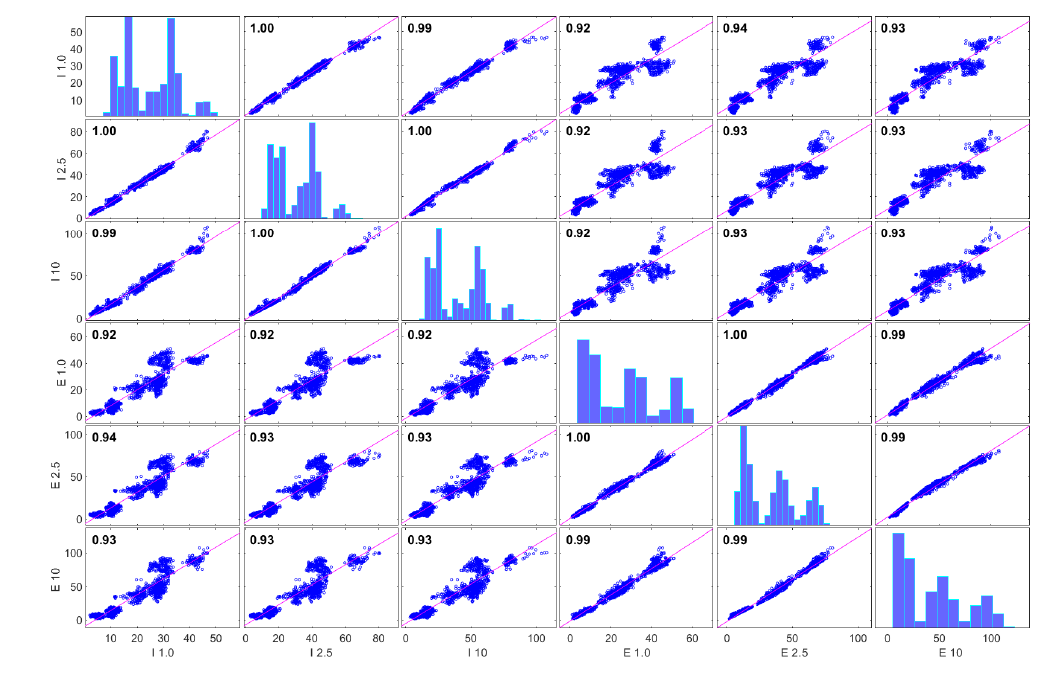
Figure 10. Histogram and correlation of measured PM concentrations without pollution source during flight.